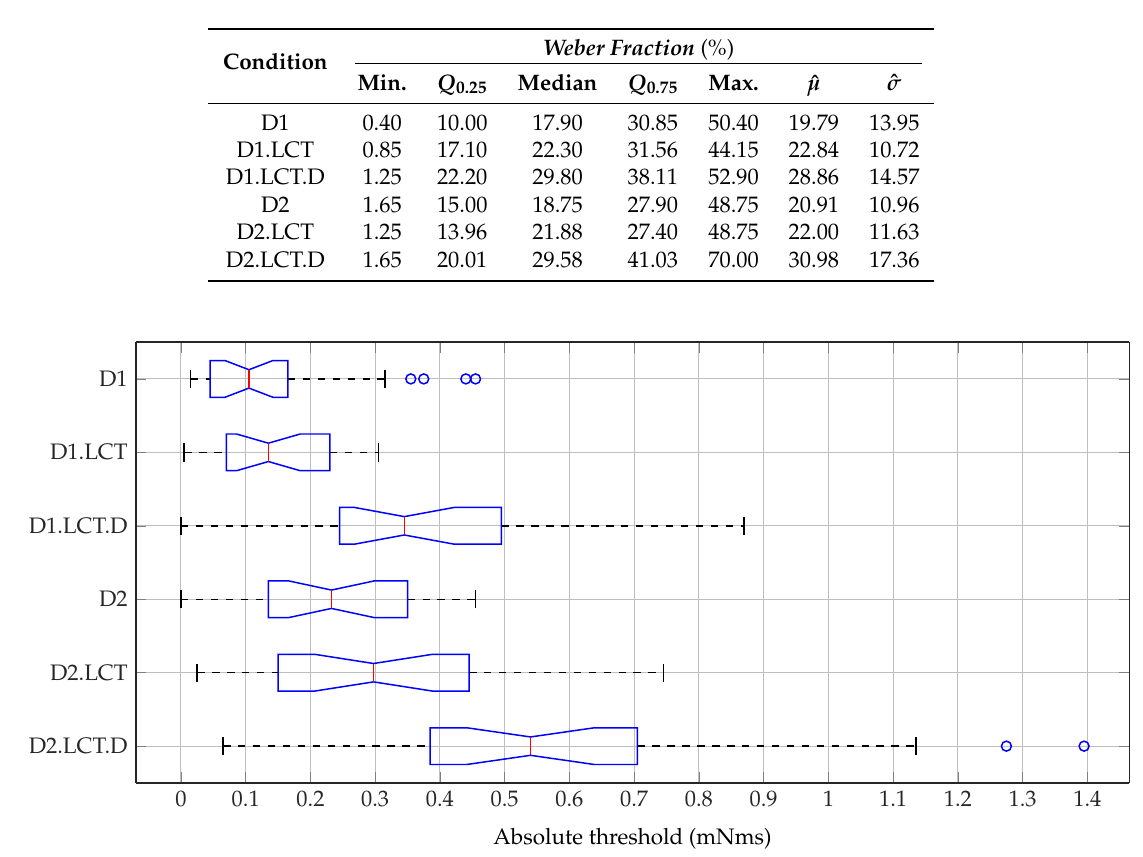
Figure 5. Boxplots of obtained absolute thresholds. Boxplots denote median (thick red vertical line) and interquartile range (IQR) between 0.25 and 0.75 quantile (blue box). Notches denote the confidence intervals ( α = 0.05) of the median values. Outliers (circles) are defined as data points with a distance of more than 1.5 IQR from 0.25 or 0.75 quantile, respectively, as indicated by the horizontal dashed lines. Stimulus conditions are coded with diameter (D1/D2), distraction (LCT/-) and detent condition (D/-). Boxplots show an increase in data span for distraction as well as detent condition. Non-overlapping notches of the central boxes hint at significant median differences of the data